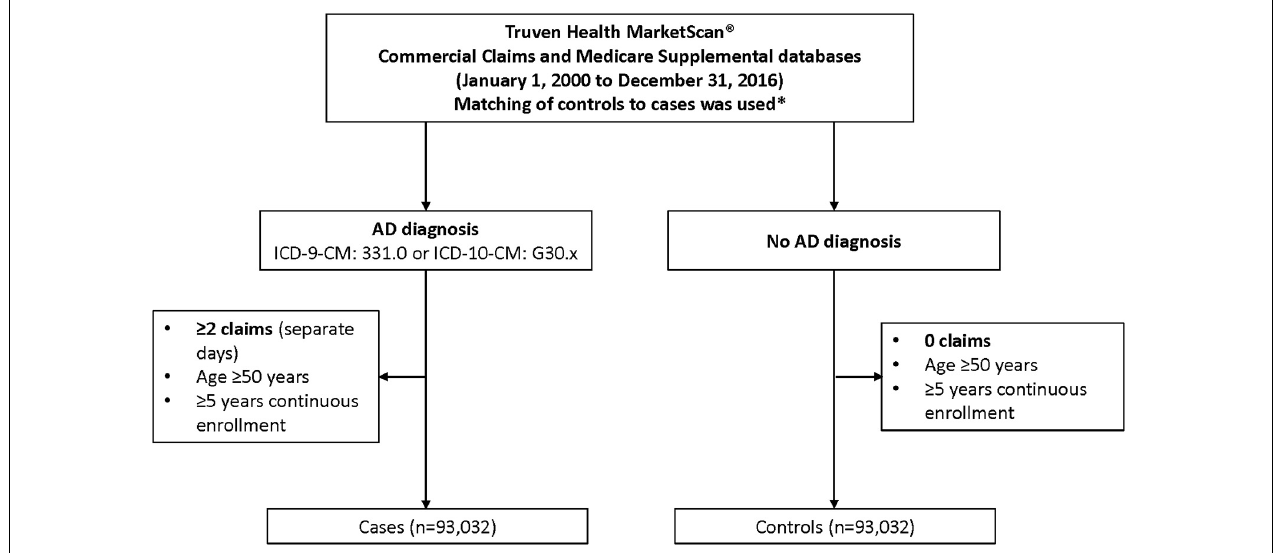
FIGURE 1 | Flowchart of case inclusion process. *Cases were required to have at least two claims for AD on separate days at age ≥ 50 years (ICD-9-CM: 331.0 or ICD-10-CM: G30.x) and a 5-year period of continuous enrollment prior to first AD diagnosis, while eligible controls for each case were required to have no claims for AD (ICD-9-CM: 331.0 or ICD-10-CM: G30.x) during the 5-year window prior to the respective cases index date. Matching was based on sex; year of birth; insurance plan type at index; relationship to insurance plan holder; (previous) employment industry; and US region. AD, Alzheimer’s disease; ICD, International Classification of